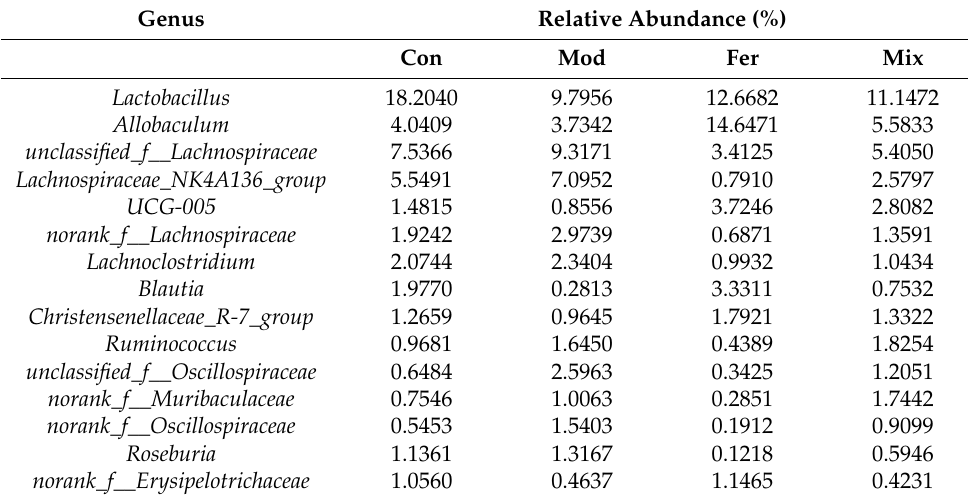
Figure 8. Composition at the level of phylum ( A ), family ( B ), and genus ( C ) of gut microbiota. Relative abundance of different group of gut microbiota was analyzed at the genus level to identify potential key bacteria. Table 2. Gut microbiota relative abundance at the genus